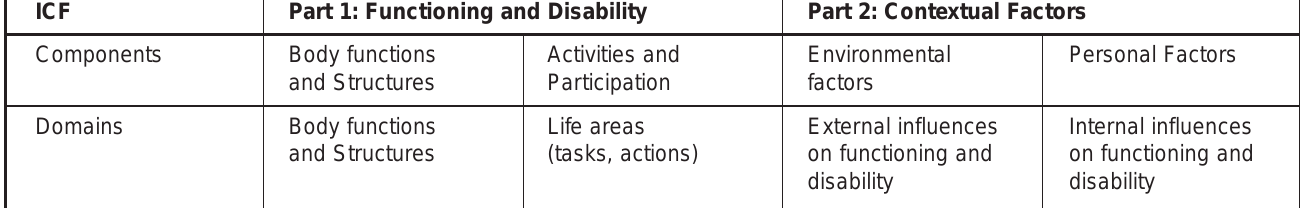
Table 1: Structure of the